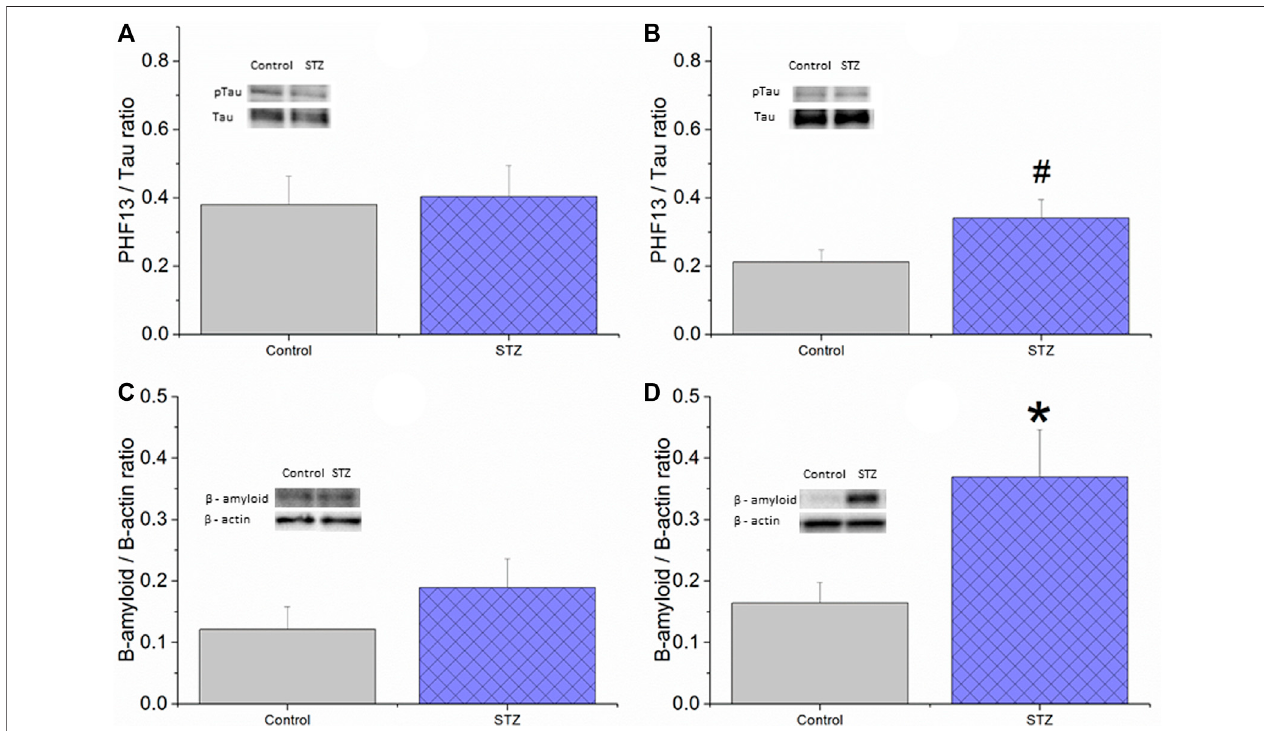
FIGURE8| Theeffectoficv.STZorcitratebuffer(control)treatmentonthetissueproteinlevelsofphospho-Tau (A,B) and β -amyloid (C,D) inEXP1 (A,C) andEXP2 (B,D) measuredbyWesternblot. Means ± SEMvaluesareshown.Therewasnosigni fi cantdifference betweenthegroupsinphospho-tau/tauratioinEXP1(unpaired t - test: t (14) = − 0.19, ns) (A) whereas a trend for an increase in the STZ group can be seen in EXP2 (unpaired t -test: t (22) = − 2.012, p = 0.06) (B) Also, there was no signi fi cantdifferencein β -amyloidlevelinEXP1(unpaired t -test: t (13)= − 1.13,ns) (C) whilesigni fi cantlyelevated β -amyloidlevelwasfoundintheSTZ-treatedgroup in EXP2 (unpaired t -test: t (20) = − 2.45, p < 0.05 (D) * < 0.05, # <